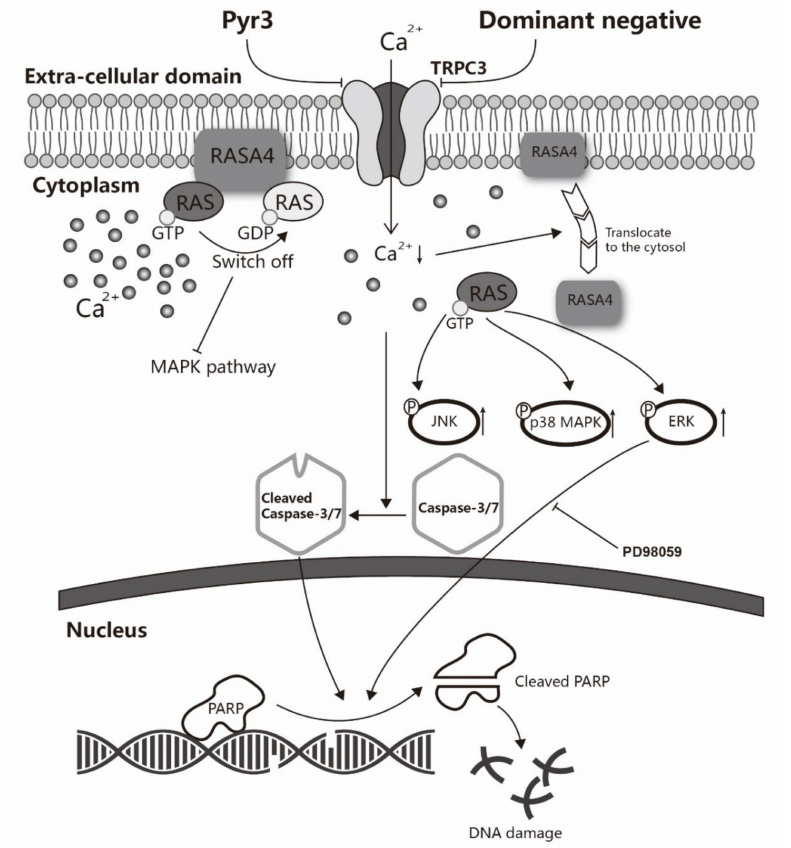
Figure 6. A schematic diagram explaining how TRPC3 acts as an anti-apoptotic regulator via RASA4-MAPK pathway in MDA-MB-231. TNBC cell line MDA-MB-231 overexpresses TRPC3 on the plasma membrane. Functional presence of TRPC3 regulates calcium entry across the plasma membrane into the cytosol. TRPC3 is oncogenic in MDA-MB-231 with suppression of ERK1 / 2 phosphorylation. TRPC3 blocker Pyr3 and DN of TRPC3 inhibit cell proliferation and induce apoptosis in a caspase-dependent manner. Blocking TRPC3 activates MAPK pathways in MDA-MB-231. RASA4, a Ca 2 + -promoted Ras-MAPK pathway suppressor, is located on the plasma membrane of MDA-MB-231 where it inhibits Ras-MAPK pathway. Ca 2 + influx through TRPC3 channel sustains the expression of RASA4 on the cell plasma membrane. Blocking TRPC3 decreases the cytosolic Ca 2 + level; this, in turn, decreases the amount of RASA4 on the plasma membrane, with concomitant activation of MAPK pathway. Taken together, functional TRPC3 channels over-expressed on the plasma membrane contribute to the apoptosis resistance of MDA-MB-231 cells through regulating Ca 2 + -dependent signaling cascade. Our study suggests that TRPC3 can be exploited as a potential molecular-based therapeutic target for